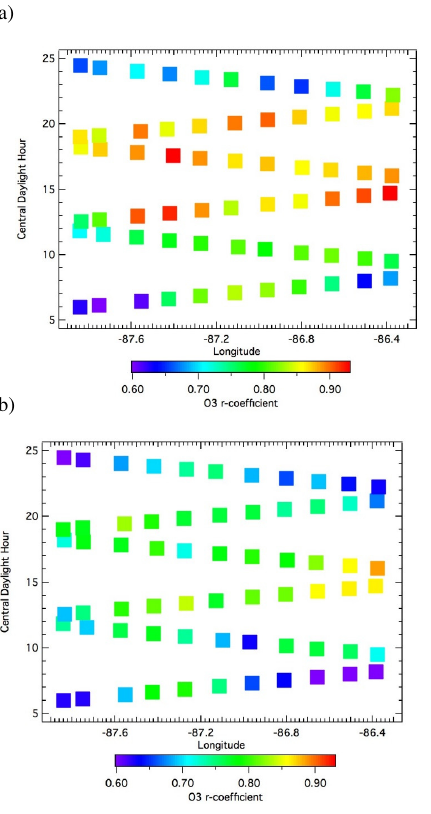
Figure 12. Correlation coefficients for model–measurement com- parison for each bin; (a) 1–24h forecast, (b) 25–48h forecast.